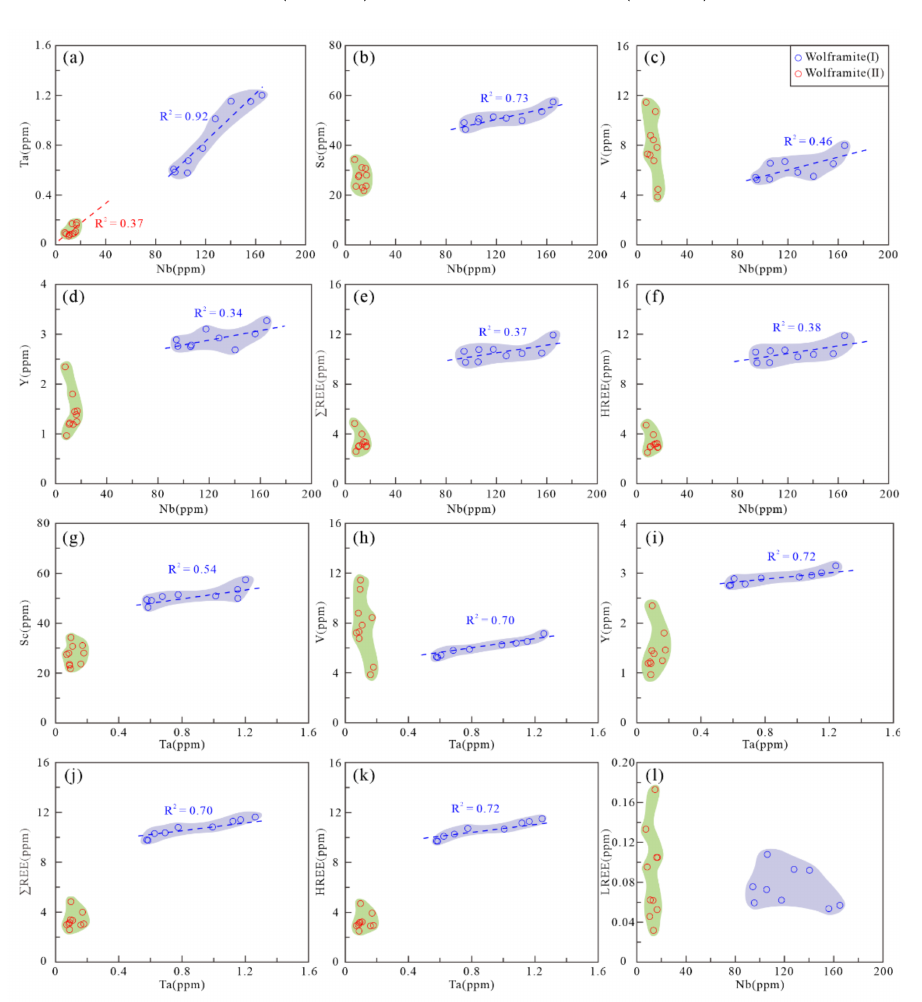
Figure 11. ( a ) Correlation plots of Nb and Ta contents. ( b – l ) correlation plots of pentavalent and trivalent cations in two generations of wolframite from the Baishitouwa